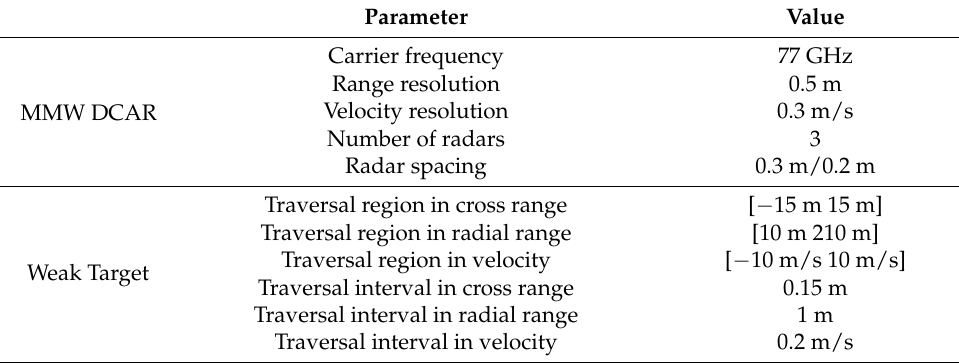
Table 2. Parameters of the MMW DCAR configuration and weak target.